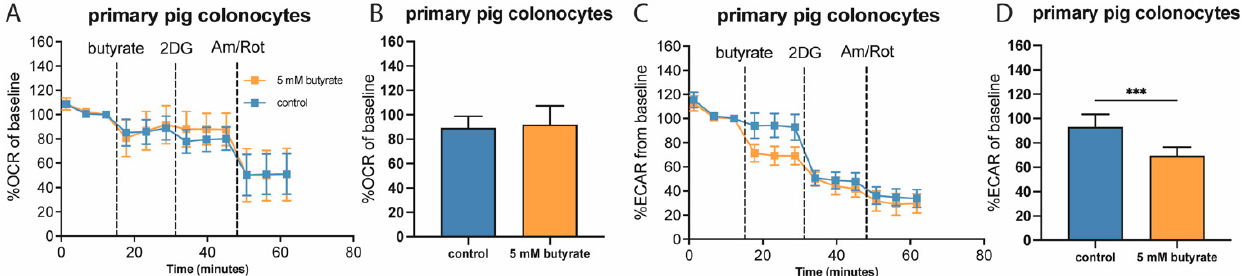
Figure 4. Metabolic flux analysis of primary pig colonocytes following acute butyrate exposure in the presence of 2.5 mM glucose. ( A , B ) Time-course and bar graph showing acute effect of control or butyrate injection and subsequent injection of 2DG and Antimycin A/Rotenone on OCR. ( C , D ) Time-course and bar graph showing acute effect of control or butyrate injection and subsequent injection of 2DG and Antimycin A/Rotenone on ECAR in primary pig colonocytes. ( n = 3. Data are shown for a colonocyte isolation of one representative pig and are presented as mean ± SD for n = 12 wells; significance was determined using the replicates of one individual using repeated-measures ANOVA followed by Bonferroni’s post-hoc analysis. p < 0.001 = ***).